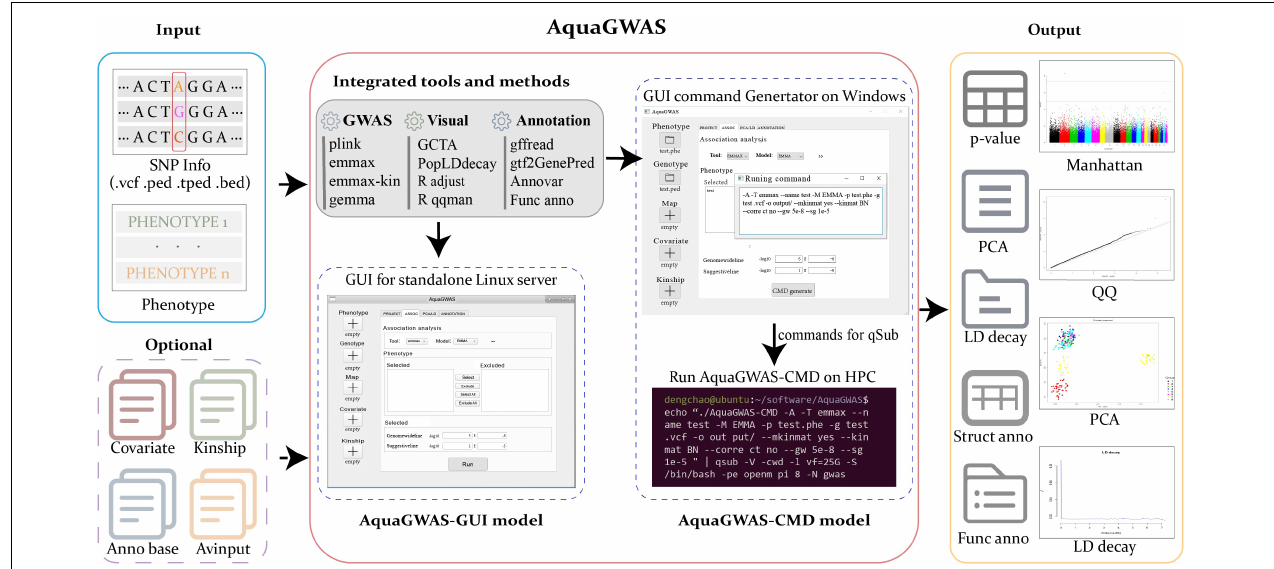
FIGURE 1 | The framework of AquaGWAS. AquaGWAS is compatible with several SNP information file formats, vcf , ped / map , tped / tfam , and bed / bim / fam . Several widely used GWAS tools, preprocessing and postprocessing, visualizations, and structural and functional annotations are integrated seamlessly, and output textual and visual analyzing